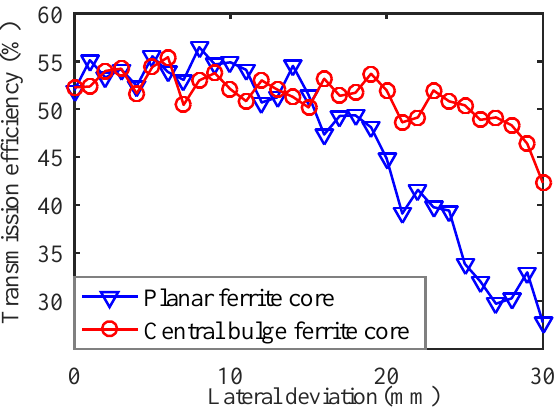
Figure 16. Curves of transmission efficiency during lateral misalignment.